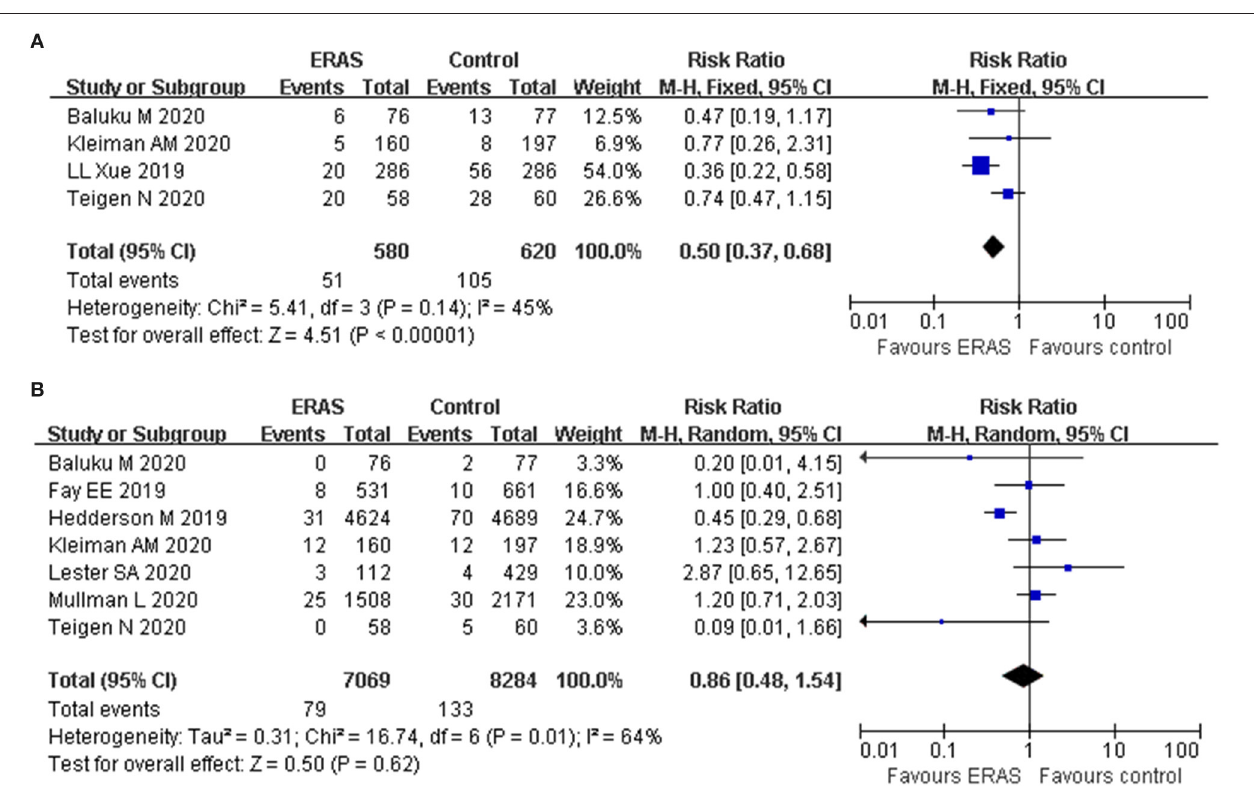
FIGURE 4 | Forest plots with (A) postoperative complication and (B) readmission